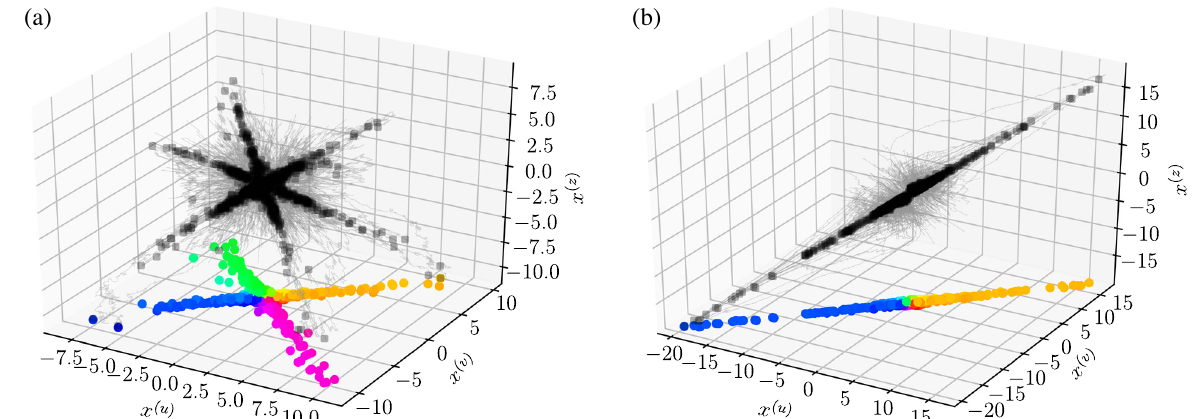
FIG. 4. Temporal evolution of the agents ’ opinions in a T ¼ 3 topic space. Evolution of opinions from numerical simulations for strong social influence ( K ¼ 3 ), controversial topics ( α ¼ 3 ), and high homophily ( β ¼ 3 ). The grey lines and black dots depict the time evolution of agents ’ opinions and the steady states, respectively. In both cases (a) and (b) the topics u and v are orthogonal. In panel (a) topic z is also orthogonal to both topics u and v . In this case an uncorrelated polarized state emerges, with weak correlations among the three opinions: ρ ð x ð u Þ ; x ð v Þ Þ ¼ 0 . 15 , ρ ð x ð u Þ ; x ð z Þ Þ ¼ 0 . 17 and ρ ð x ð v Þ ; x ð z Þ Þ ¼ 0 . 11 . In panel (b) topic z has a finite overlap with both topics u and v , i.e. δ uz ¼ δ vz ¼ π = 4 . In this case, an ideology state emerges: opinions with respect to the three topics are correlated, ρ ð x ð u Þ ; x ð v Þ Þ ≃ ρ ð x ð u Þ ; x ð z Þ Þ ≃ ρ ð x ð v Þ ; x ð z Þ Þ ≃ 1 . Note that for simplicity of illustration the opinion space in panel (b) is depicted using orthogonal axes, although δ uz ¼ δ vz < π = 2